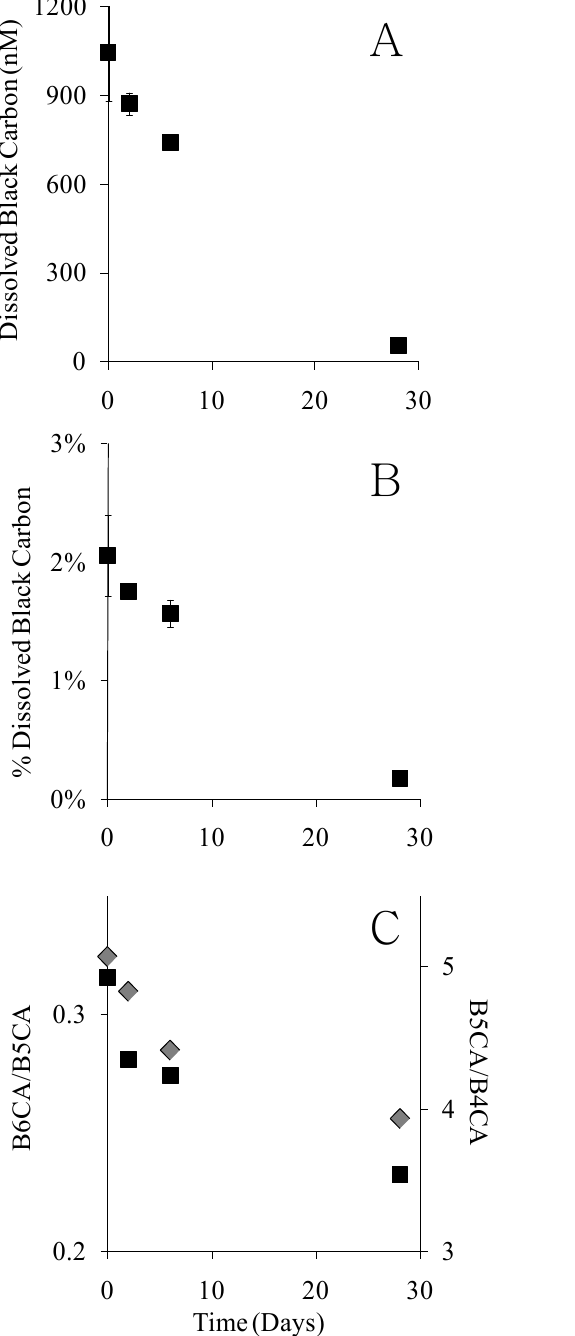
Fig. 1. Photodegradation of dissolved black carbon (DBC) in North Atlantic Deep Water over the course of a 28 day irradiation. Panel A: DBC concentration. Panel B: DBC as a percentage of total dis- solved organic carbon. Panel C: ratios of DBC derived benzenecar- boxylic acids. Ratios decrease as DBC becomes less condensed. Black squares are B6CA/B5CA. Grey diamonds are B5CA/B4CA.